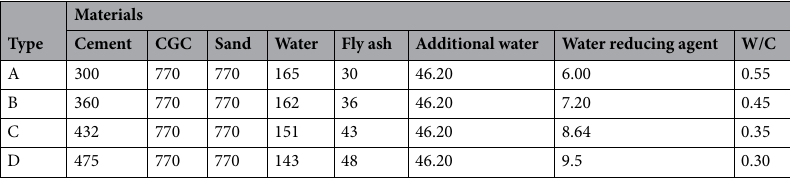
Table 4. Mixed proportions of CGCLAC (kg m −3 ).